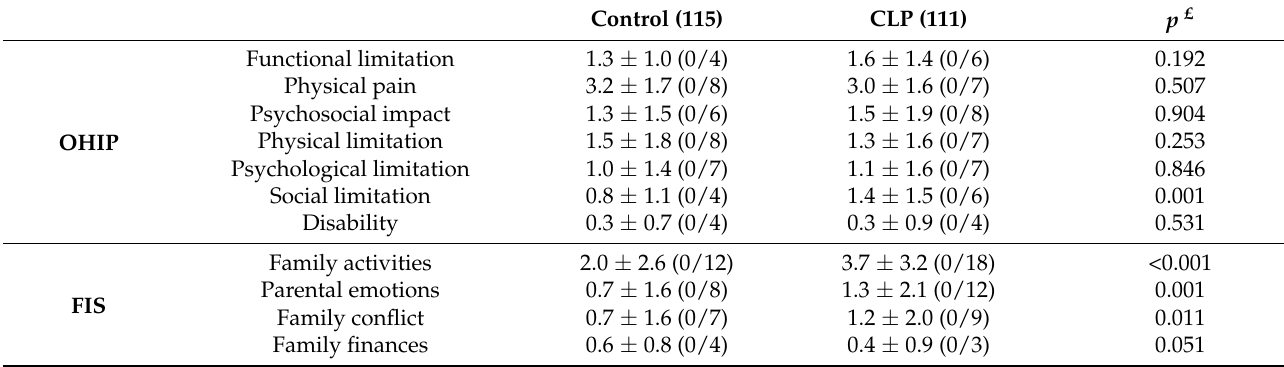
Figure 2. Correlation between patients’ and parents’ quality-of-life assessment. Table 4. OHIP and FIS answers distribution regarding the domains.